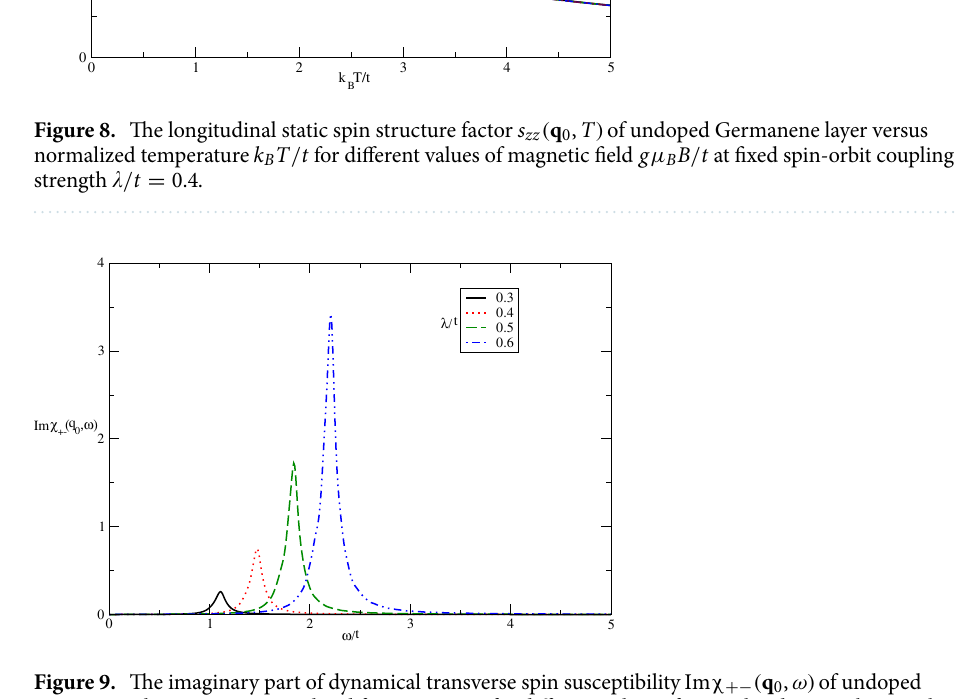
Figure 9. The imaginary part of dynamical transverse spin susceptibility Im χ Germanene layer versus normalized frequency ω/ t for different values of normalized spin-orbit coupling (cid:31) / t at 0.05 . The magnetic field is considered to be fixed temperature k B T / t =